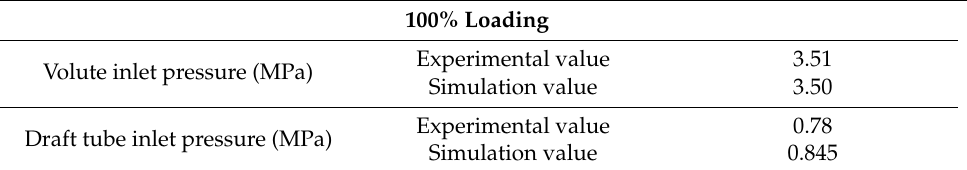
Figure 3. Diagram of the pressure pulsation measuring point location. Table 3. Comparison of the mean values under pressure. Table 3. Comparison of the mean values under pressure.